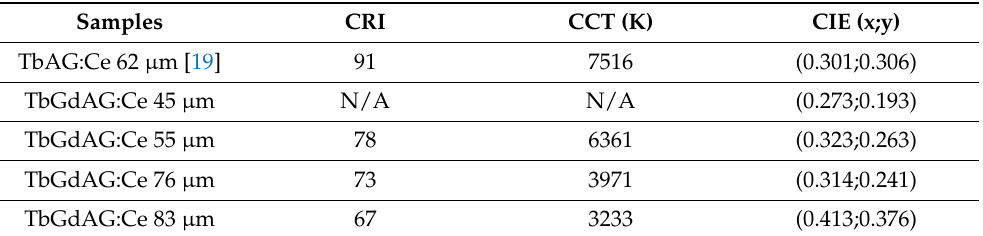
Table 1. Comparison of the CRI, CCT and CIE coordinates of TbGdAG:Ce SCFs in comparison with TbAG:Ce SCF counterpart.